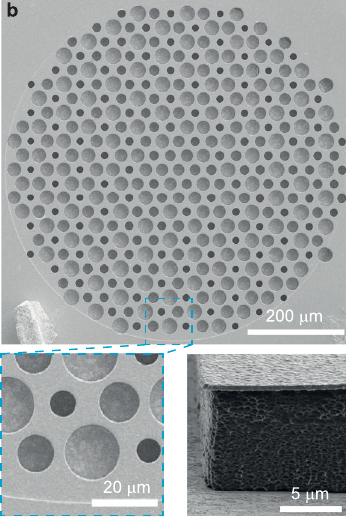
Fig. 1 | Electrically pumped quantum cascade laser (QCL) based on a photonic Majorana zero mode (MZM). a An air-hole structure is patterned into the top Au/ QCL layers. The top and bottom Au layers work as electric conductors for pulsed pump current injection, aswellas tight mode con fi nement in the verticaldirection due to the small Ohmic losses at terahertz frequencies. The region outside the